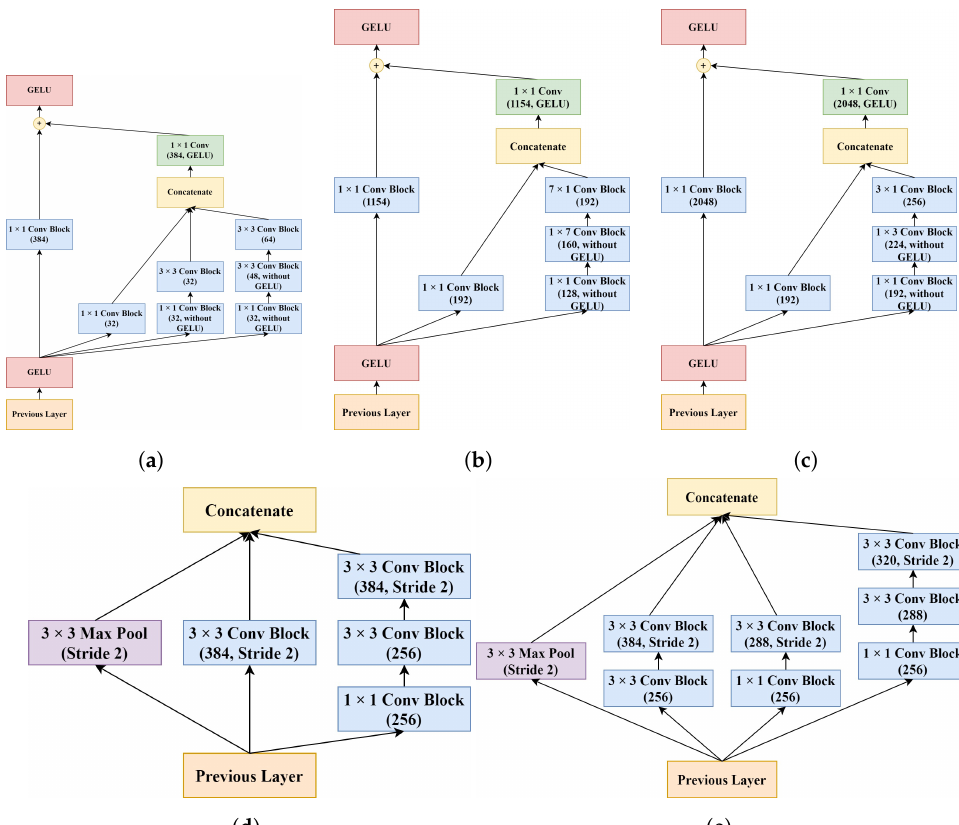
Figure 5. The flow diagram of the modules used in the encoder path of the RIU-Net: ( a ) Module A,